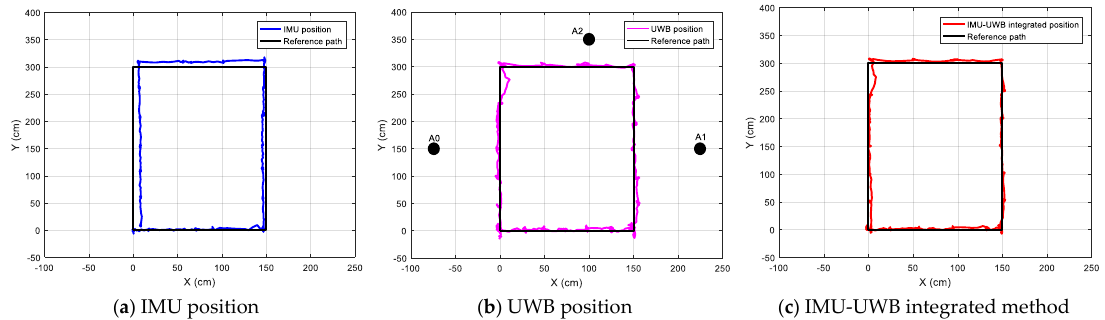
Figure 13. The measured locations for walking along a rectangular path.